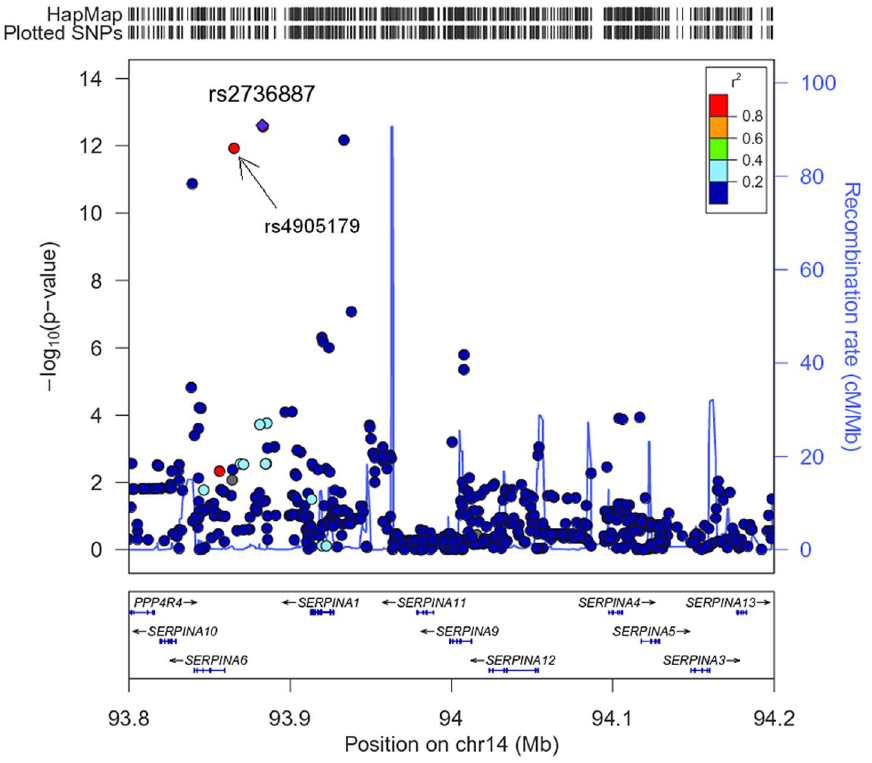
Figure 2. Regional plot for the SERPINA gene cluster (93.8–94.2 Mb on chromosome 14q32.13, reference panel: NCBI build 36.3). Presented are -log(10) p-values and LD (r 2 ) with top-ranking SNP rs2736887 (purple diamond) for all SNPs in this region. The blue line shows recombination rate.